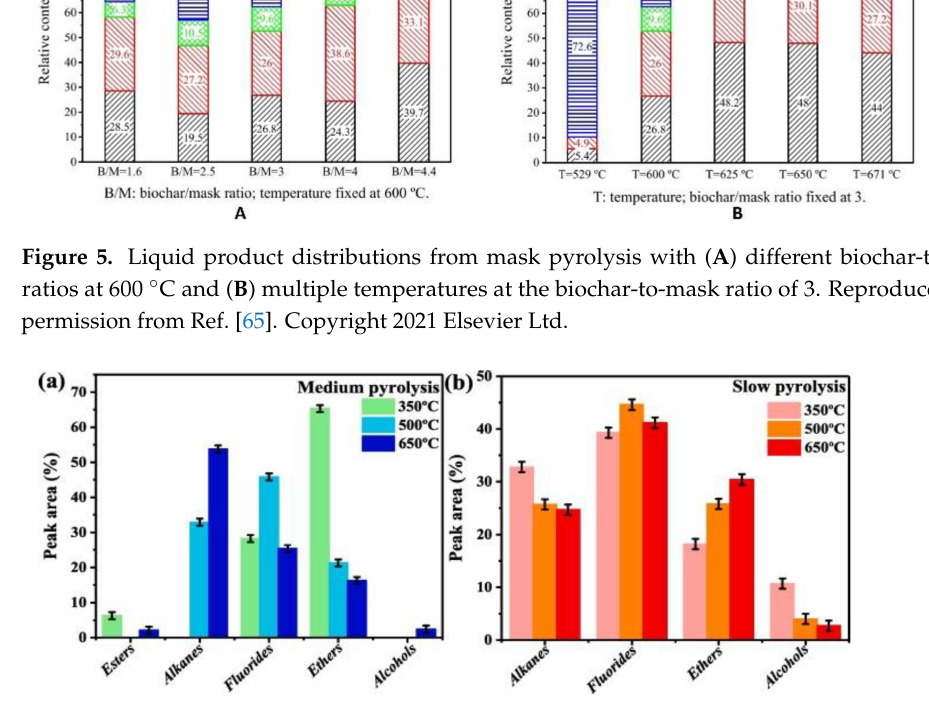
Figure 6. Liquid product distributions from pyrolysis of the middle layer of disposable masks at 350 ◦ C, 500 ◦ C and 650 ◦ C with ( a ) medium mode and ( b ) slow mode. Reproduced with permission from Ref. [42]. Copyright 2021 Elsevier